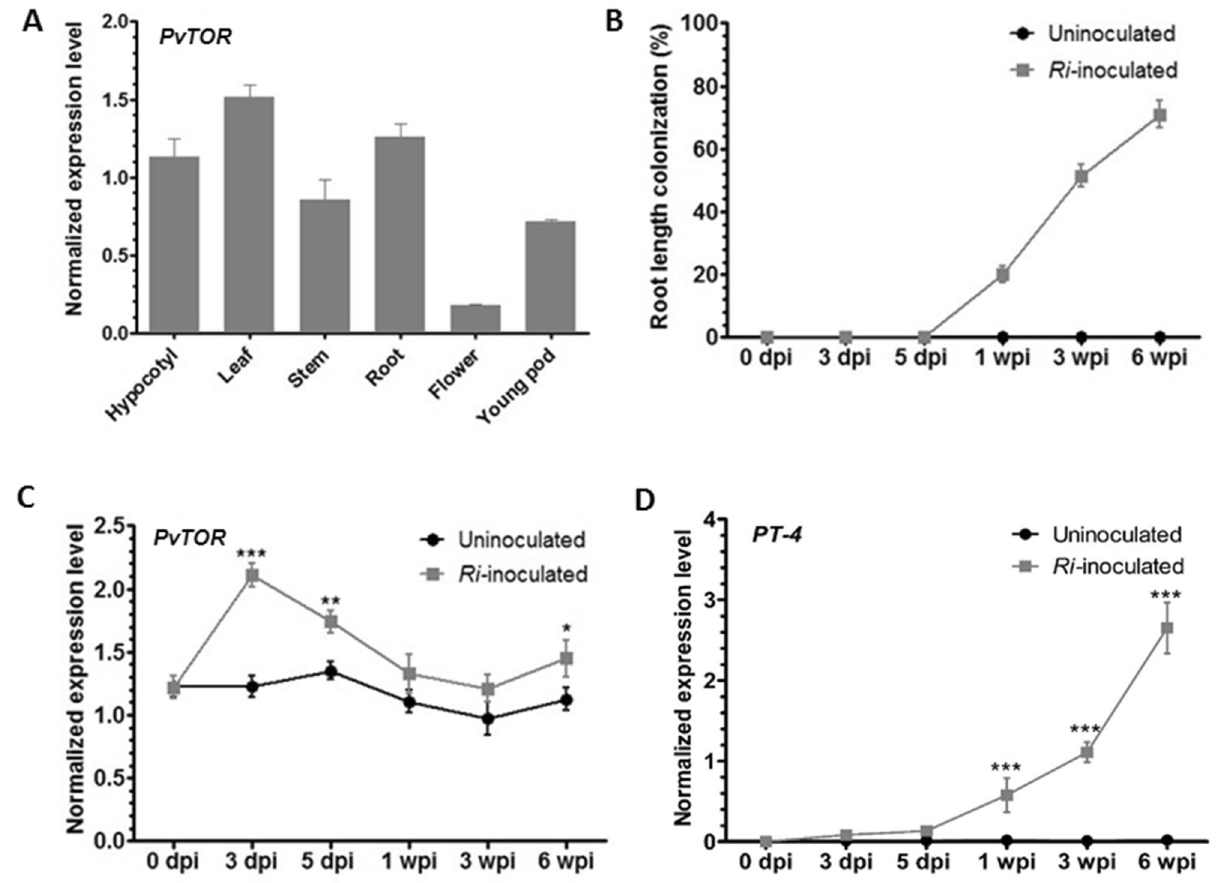
Figure 1. Expression of PvTOR in various tissues and in mycorrhized wild-type P. vulgaris plants. ( A ) RT-qPCR analysis of PvTOR transcript levels in different vegetative and reproductive organs. ( B ) AM fungal colonized roots were stained and assessed for percent mycorrhizal root length colonization under a light microscope at different time points. The remaining root portions were used for RT-qPCR analysis to measure ( C ) PvTOR and ( D ) PT-4 expression in AM roots at different time points. Transcript accumulation was normalized to the expression of EIF4a and IDE , which were used as reference genes. For C and D, the statistical significance of differences between uninoculated and Ri -inoculated roots was determined using an unpaired two-tailed Student’s t -test (* P < 0.05; ** P < 0.01; *** P < 0.001). For A–D, error bars refer to the SE of the mean of three biological replicates (n > 9). Ri , R. irregularis ; dpi, days post inoculation; wpi, week(s) post